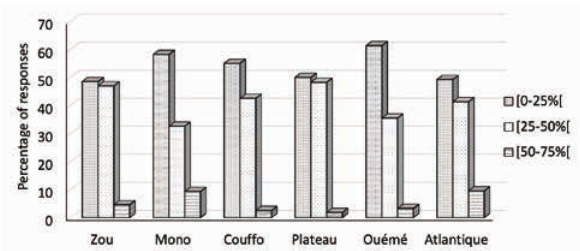
Figure 3: Farmers’ perception of percentage of maize yield loss